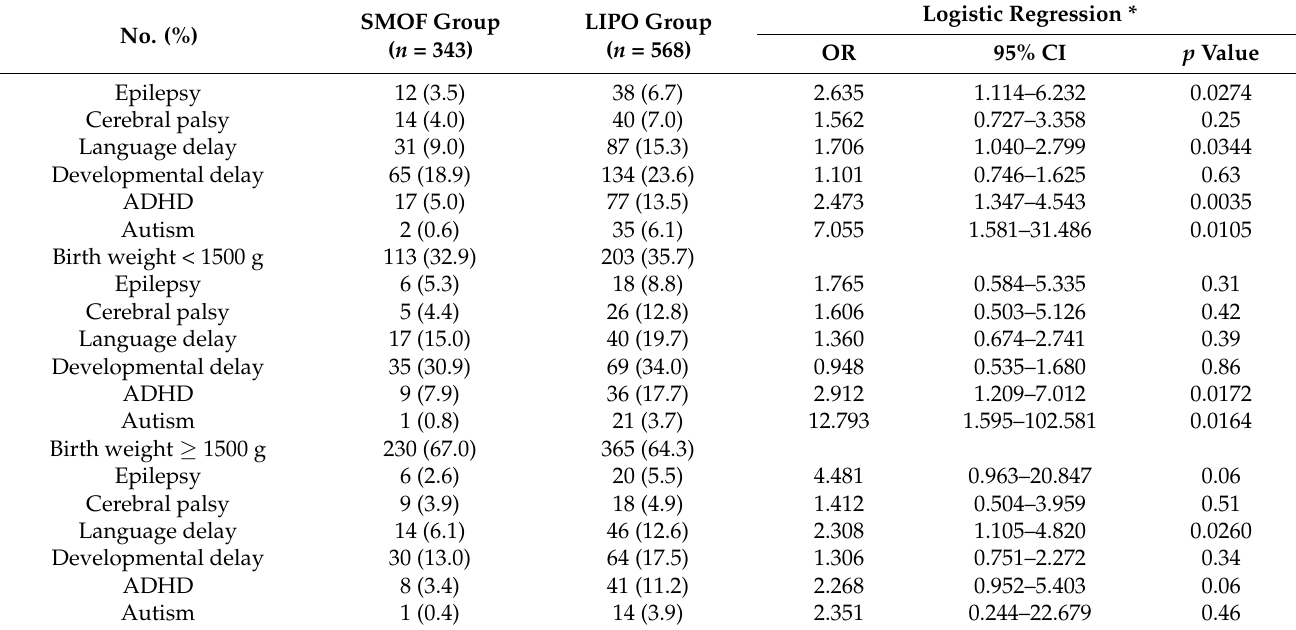
Table 4. The neurodevelopmental outcomes of SMOF and LIPO groups at five years old as corrected age ( n =